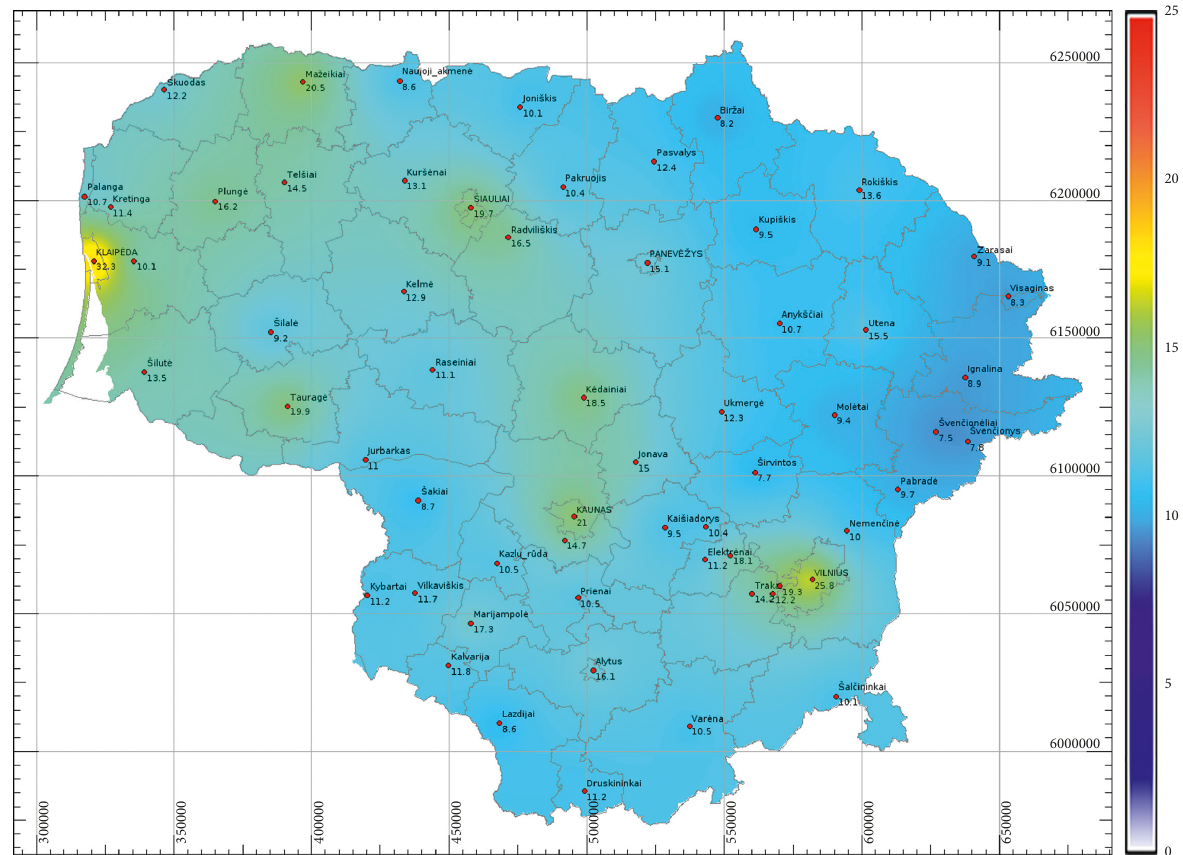
Figure 7: Annual mean concentrations of NO 2 in the zone (58 cities) for the period from 3 November 2010 to 4 July